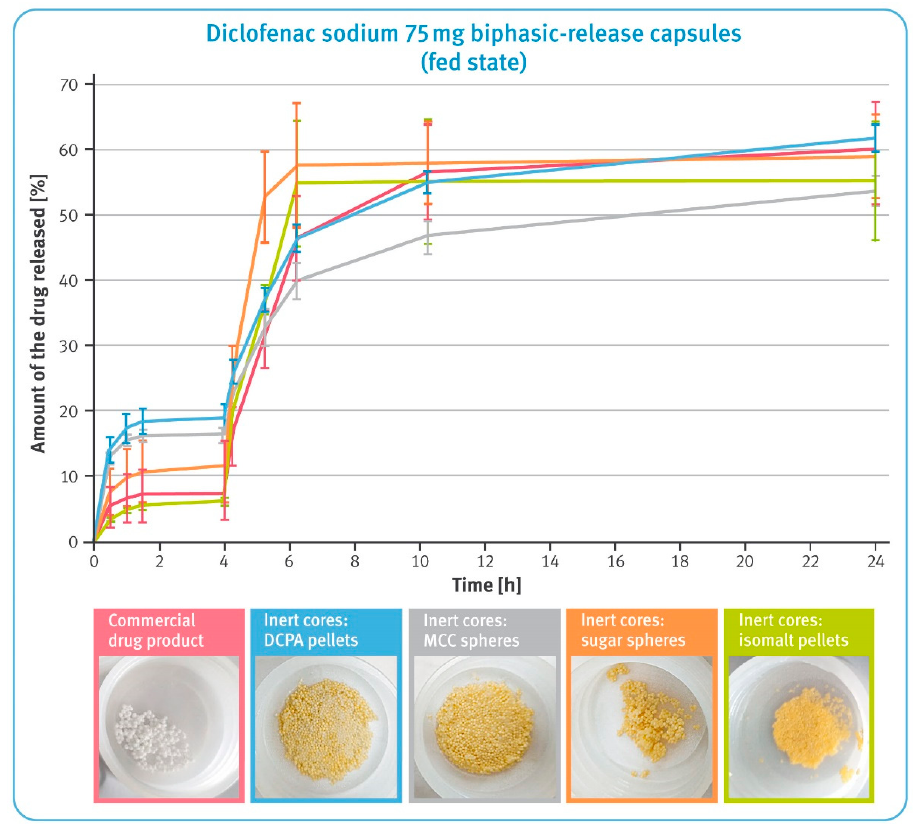
Figure 8. The release of the drug substance from diclofenac sodium 75 mg biphasic-release hard gelatin capsules under conditions simulating pH changes in the fed state in USP apparatus 3 (mean of n = 3, SD indicated by the error bars). Underneath are residues of diclofenac sodium BPR capsules in tubes after completing the test.